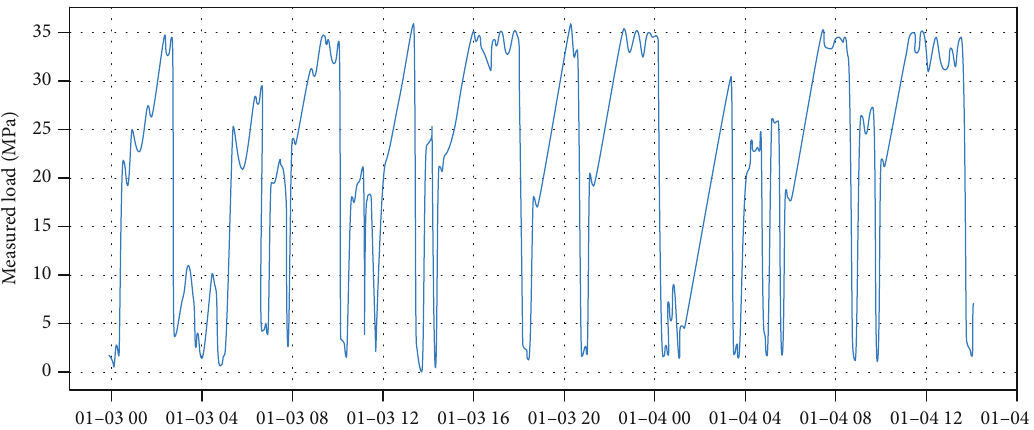
Figure 1: Monitoring data of hydraulic support